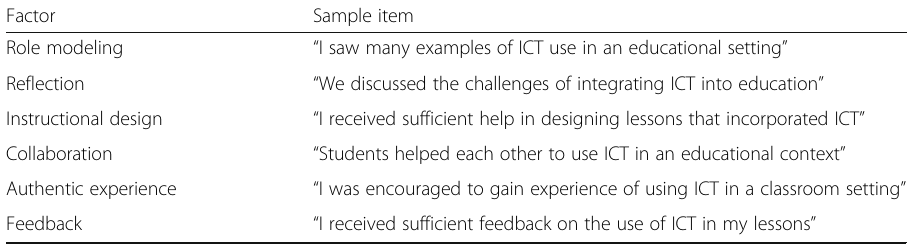
Table 1 SQD-scale Sample Items Factor Sample item